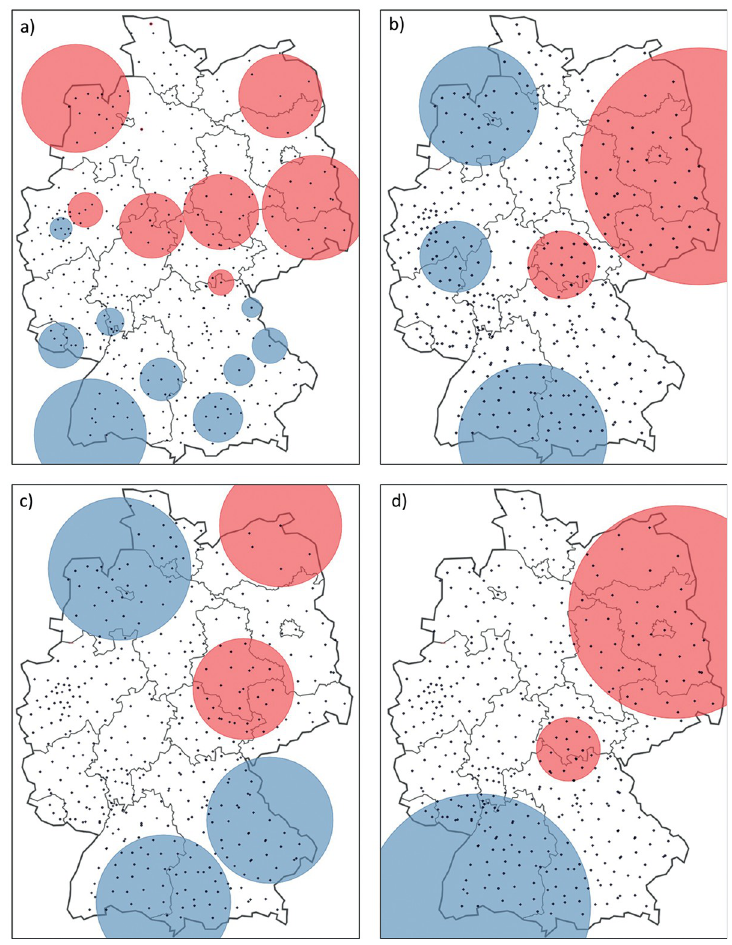
Fig 4. Spatiotemporal cluster (only significant clusters) analyses on county level for a) affective disorders, b) diabetes, c) hypertension and d) obesity (maps based on Andrees et al. [36]). High cluster = red, low clusters = blue.